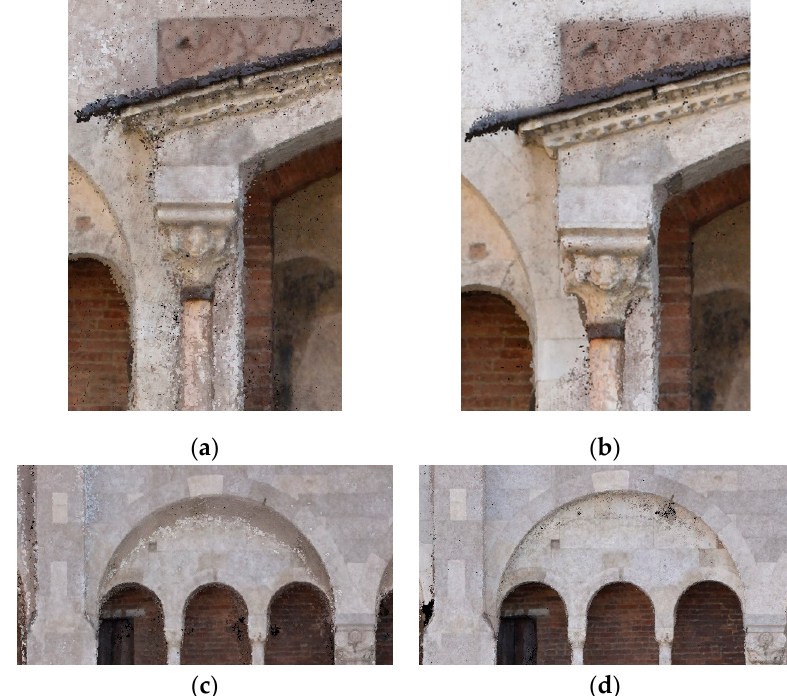
Figure 8. Qualitative (visual) evaluation and comparisons of the dense point clouds derived from the standard photogrammetric workflow ( a , c ) and after the proposed filtering method ( b , d ). Less noisy data and more details are clearly visible in ( b , d ).